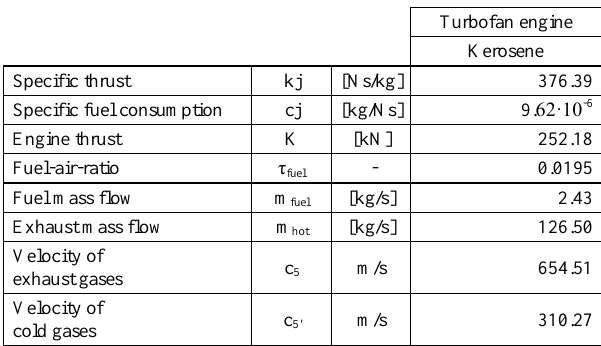
Table 5. Results of thermodynamics analysis of modified turbofan engine configuration